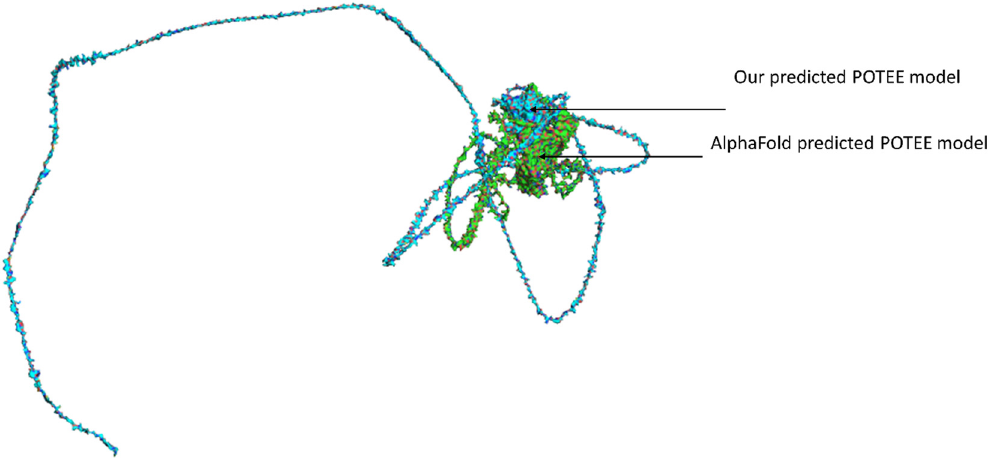
Figure 5: Validating predicted POTEE model with AlphaFold POTEE model.